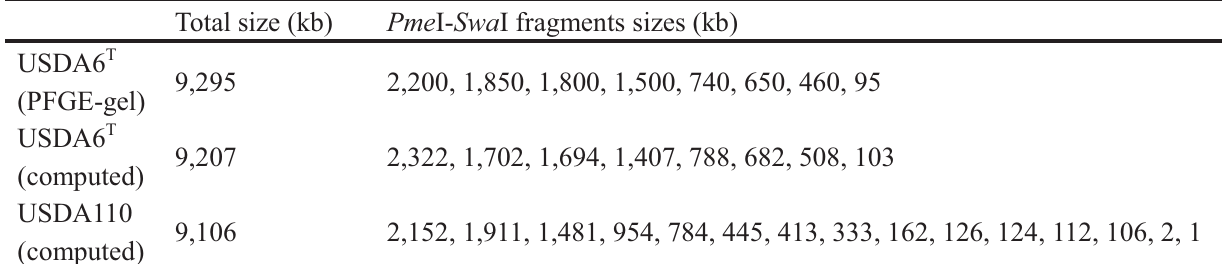
Table 1. Size of DNA fragments resulting from restriction digestion of the USDA6 T